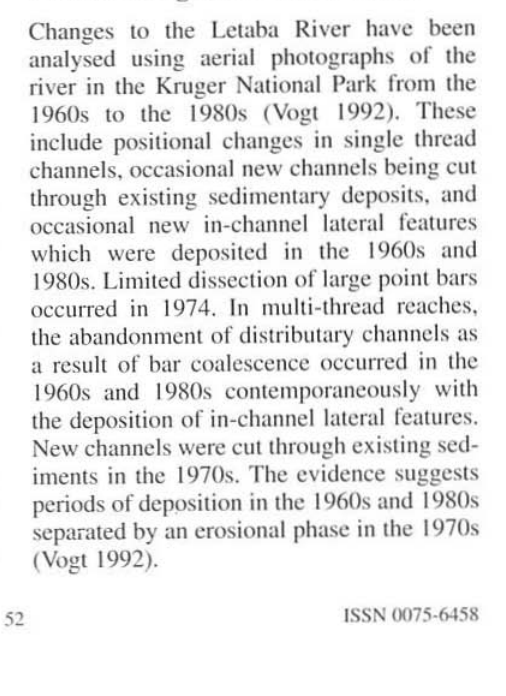
Fig. 6: ,\ 11 ~lIu\'i,ll singte thread I:hannct !ype on Ihe LC!:Iba River in Ihe Kruger Nali()n~1 Park (W,l\'C trains can be M:cn in !he lOp right uf Ihe ,and ~hcc!).